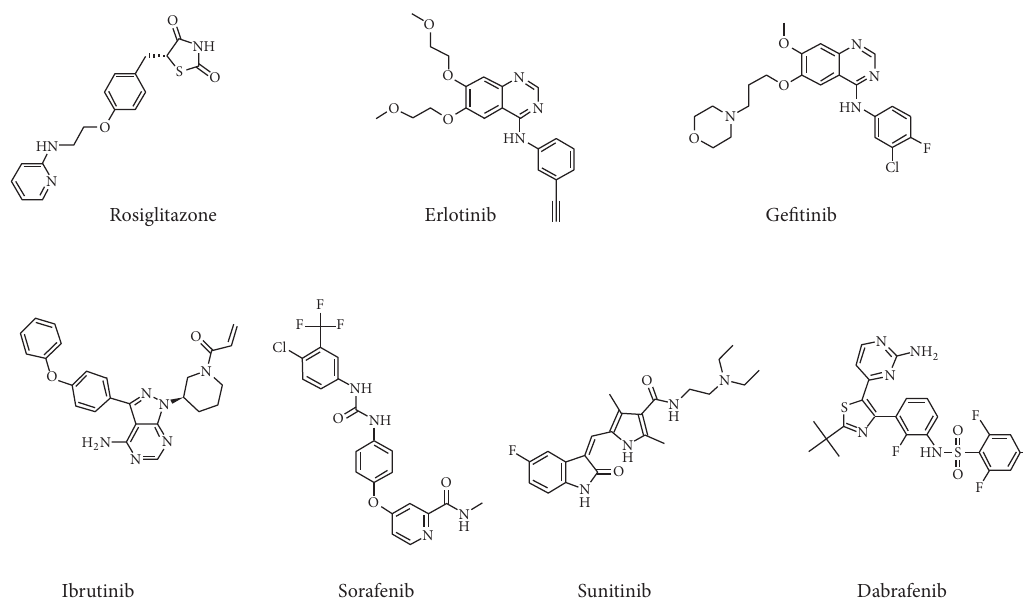
Figure 1: Structures of PPAR 𝛾 full-agonist rosiglitazone and FDA approved kinase